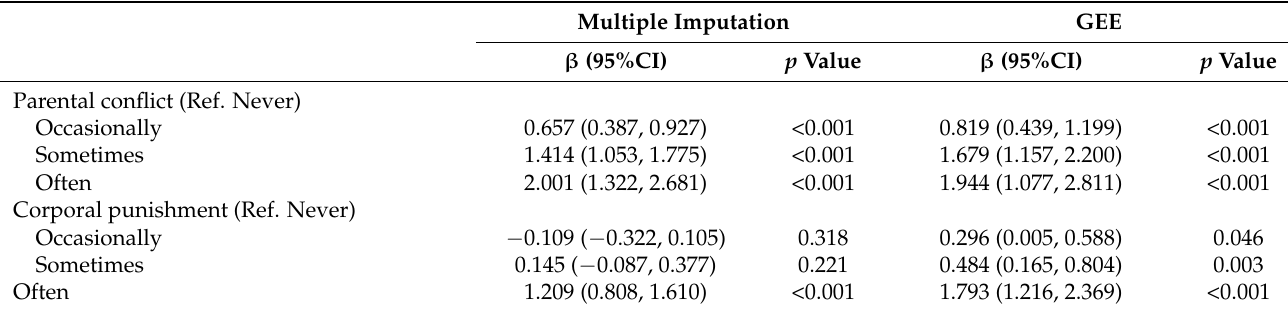
Table 4. Robustness check.